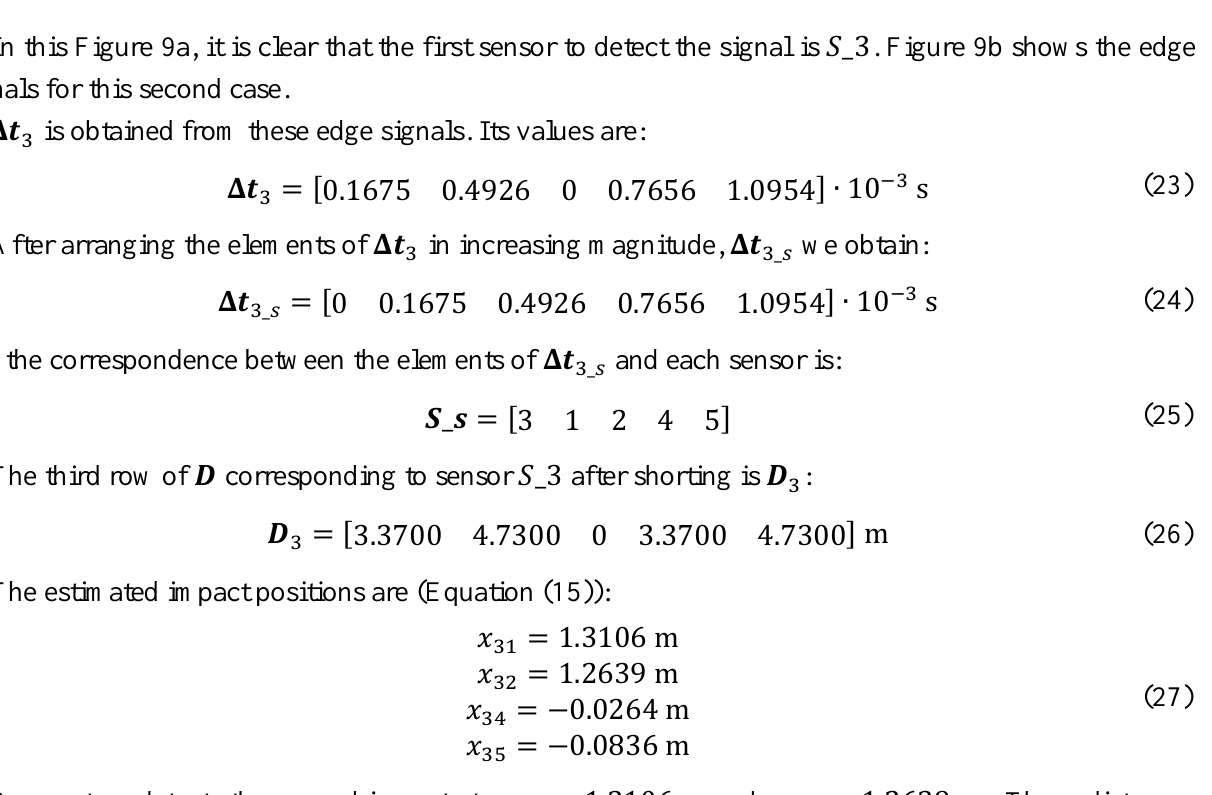
Figure 9. ( a ) Impact on 𝑃_2 . Detailed view; ( b ) Edge signals when impacting on 𝑃_2